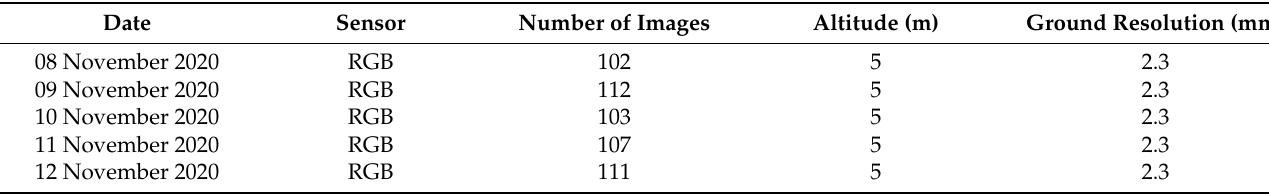
Table 1. Details of remote sensing data